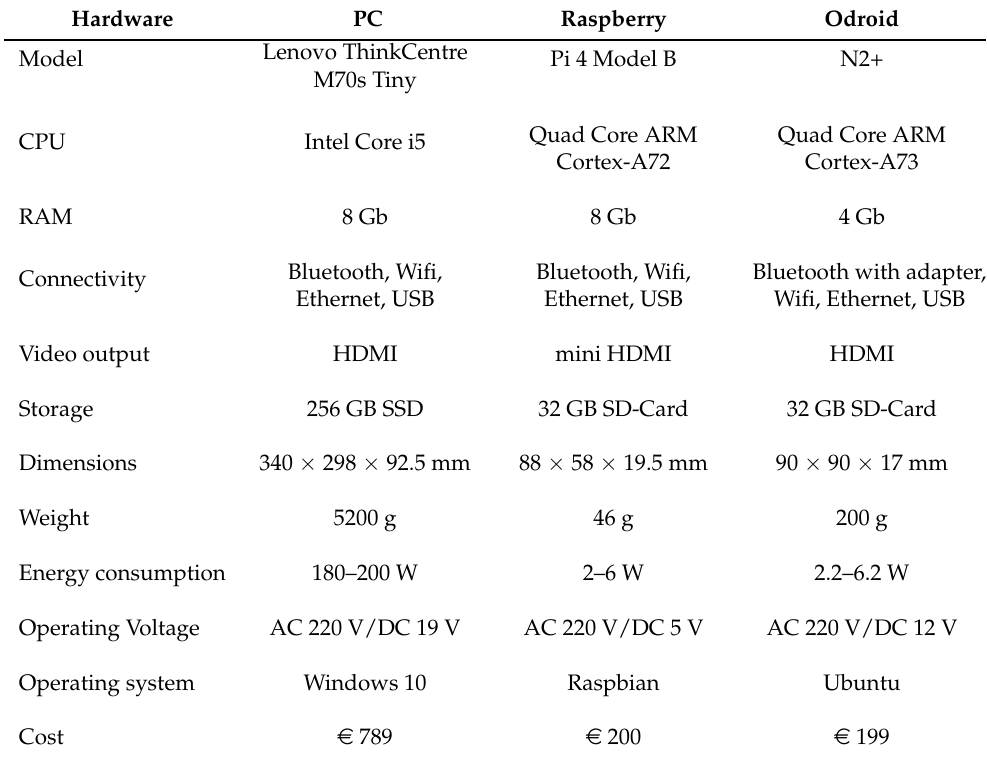
Table 4. Comparison of embedded systems versus